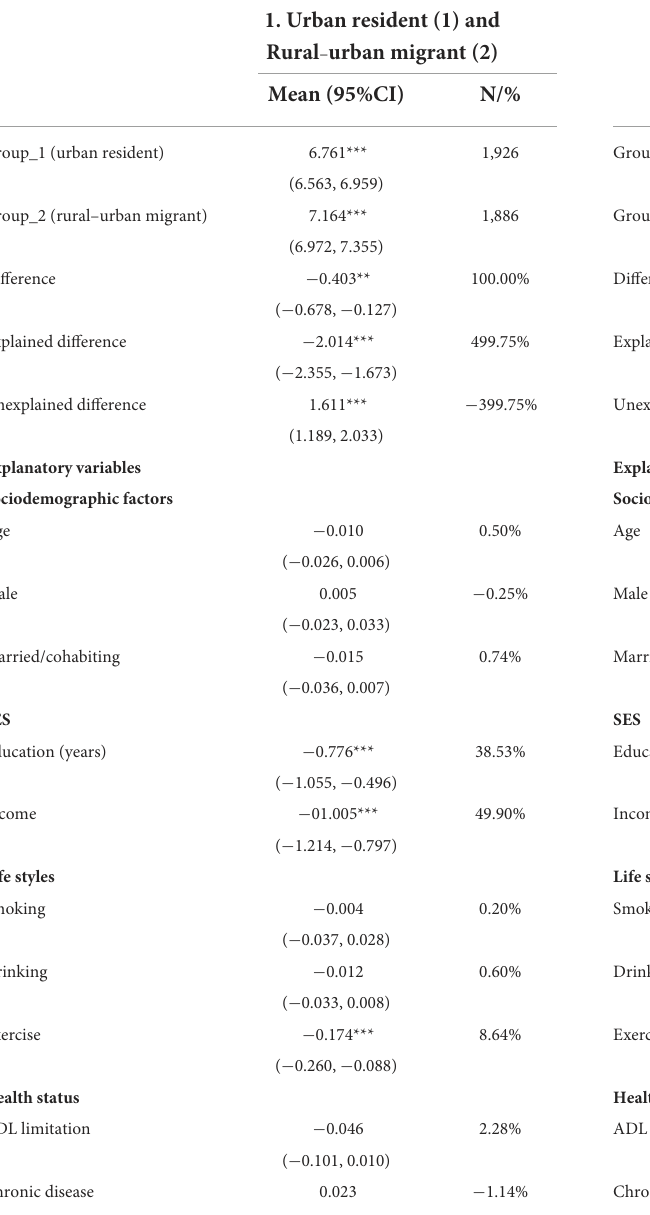
TABLE 4 Blinder–Oaxaca decomposition of the gap in depressive symptoms between the urban resident and rural–urban migrant samples (weighted).